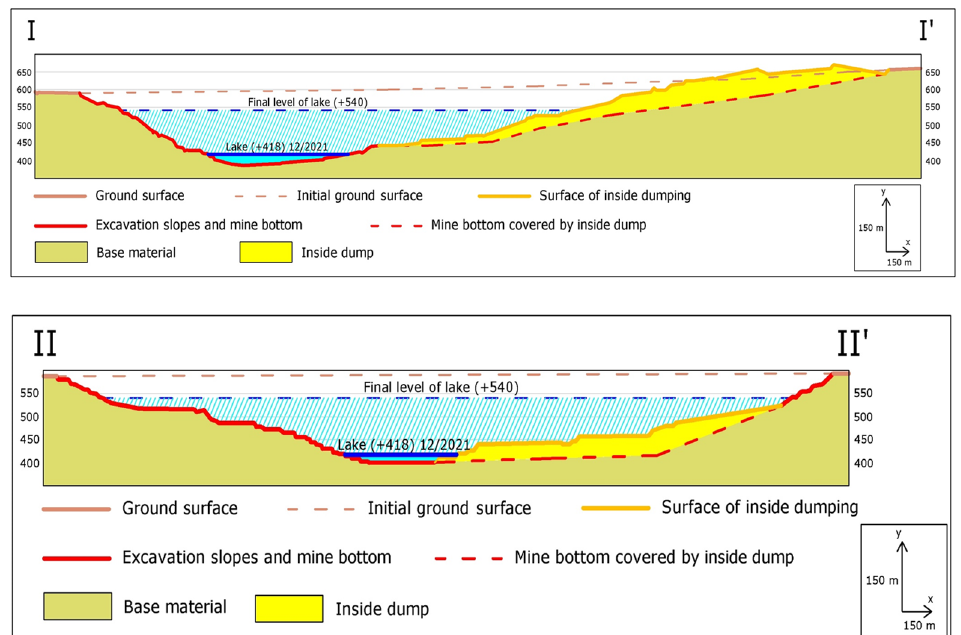
Figure 6. Sections ( I-I ′ ) and ( II-II ′ ) of the Amyntaion mine (locations are shown in Figure 5). The recent lake level is presented with continuous blue line, while the predicted lake level is presented with dashed blue line.